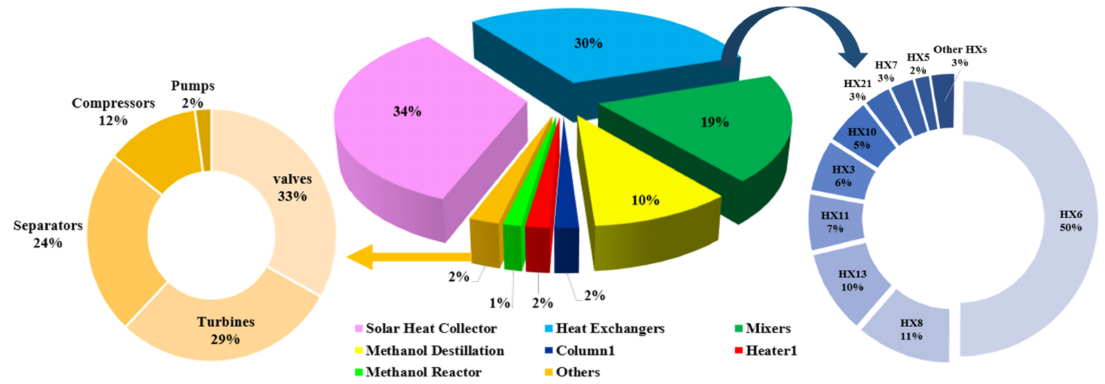
Figure 9. The share of each piece of equipment in the total exergy